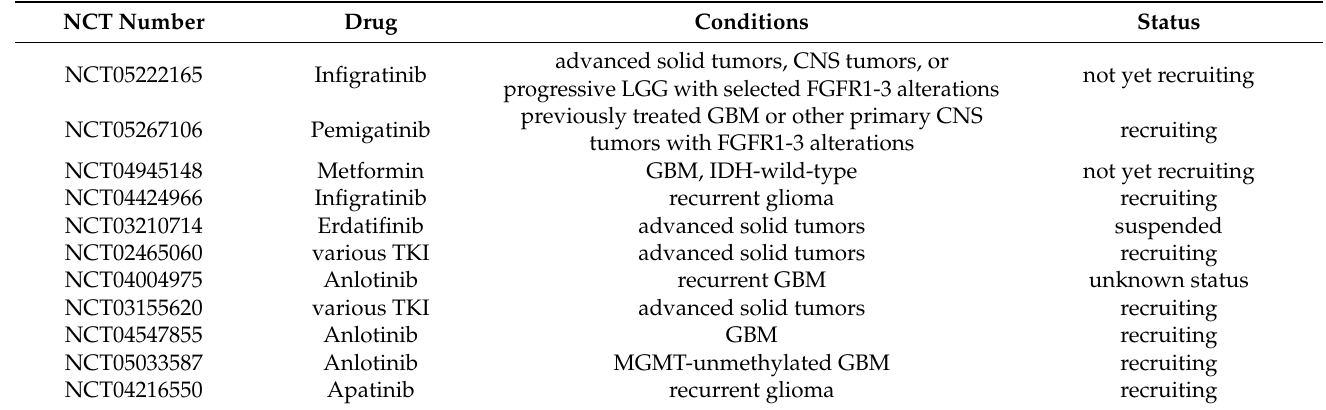
Table 2. Currently ongoing clinical trials for treatment targeting FGFR-signaling in human glioma. Not all trials are limited to FGFR-fusion-positive tumors (www.clinicaltrials.gov, accessed on 13 May